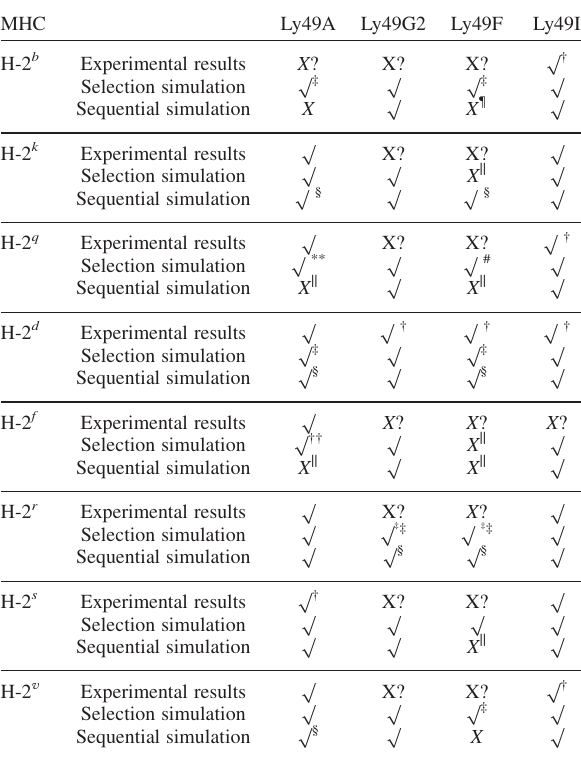
TABLE IV MHC-I reactivities to Ly49 receptors according to the selection and the sequential models*